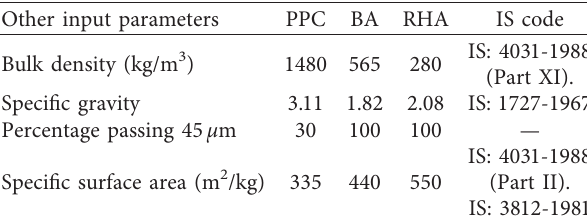
Table 4: Input parameter values for ANN networks.